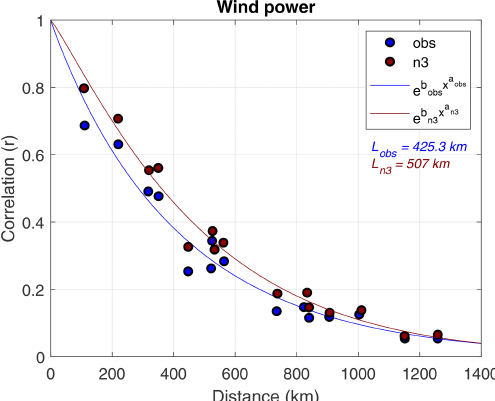
Figure 8. Correlation of wind power time series as a function of the distance between the connected site pairs for the observa- tions (obs, blue) and NORA3 data (n3, red). An exponential fit is also shown ( e bx a ) for both data sets with the corresponding decor- relation lengths, L